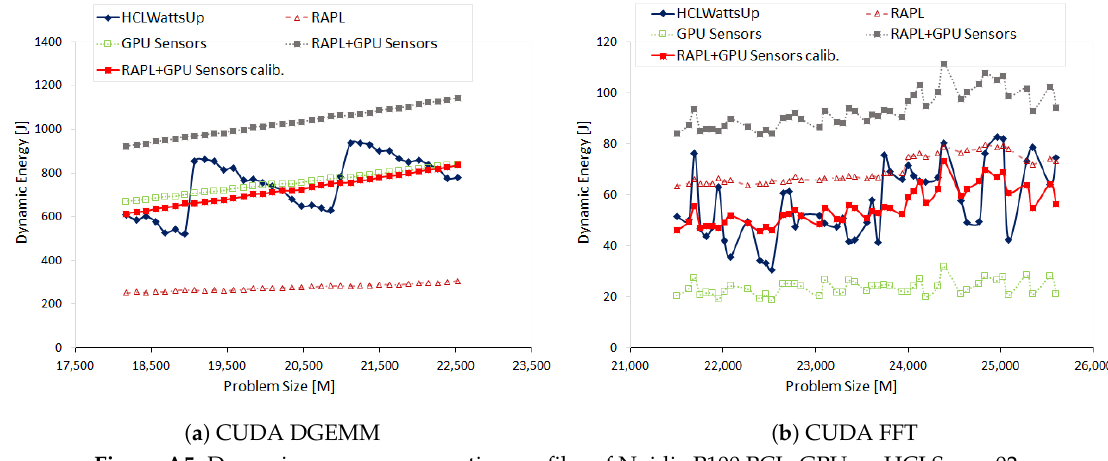
Figure A5. Dynamic energy consumption profiles of Nvidia P100 PCIe GPU on HCLServer02.